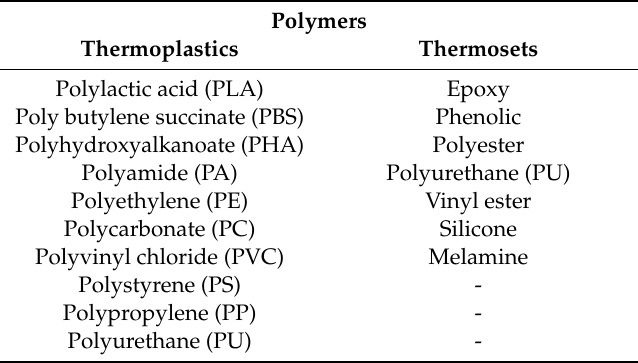
Table 4. Major polymers used as a matrix for